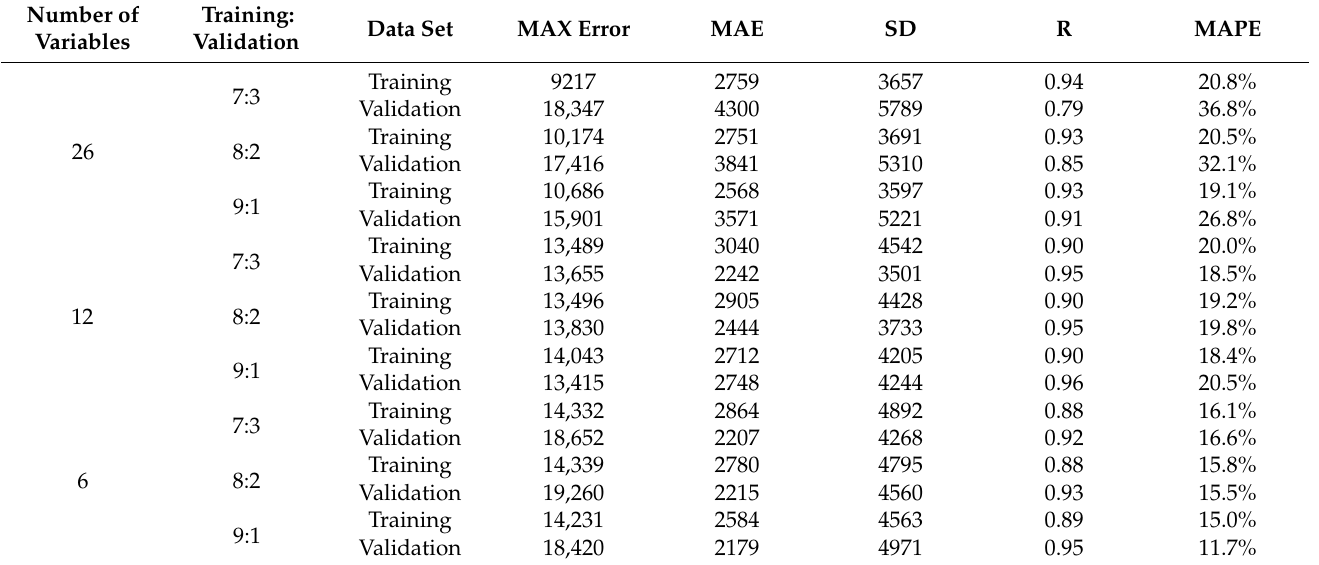
Table A1. Analysis of the results of the MLR model for electricity consumption.